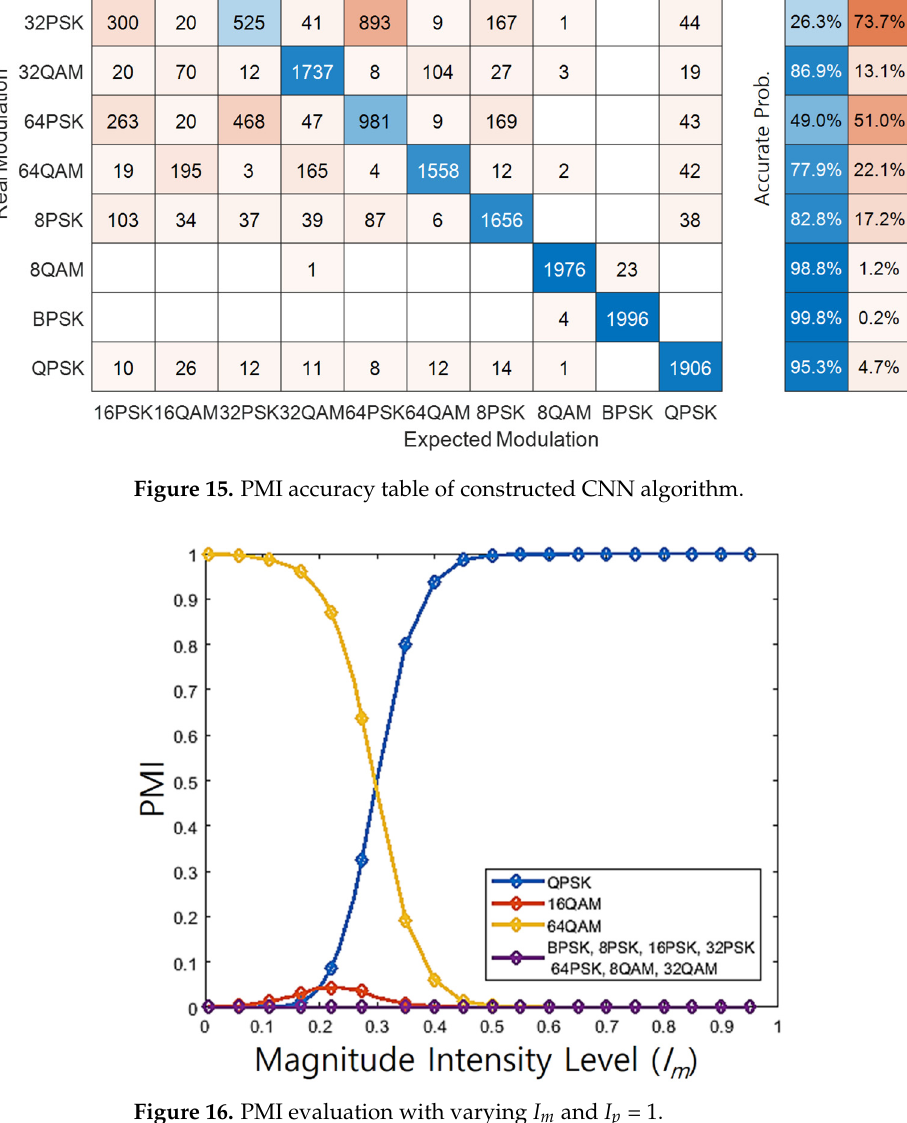
Figure 17. PMI evaluation with varying I m and I p = 4. 7. Conclusions As EW attacks have become more varied with the development of modern technolo- gies, a proper defense system for a specific type of attack or a robust defense system is